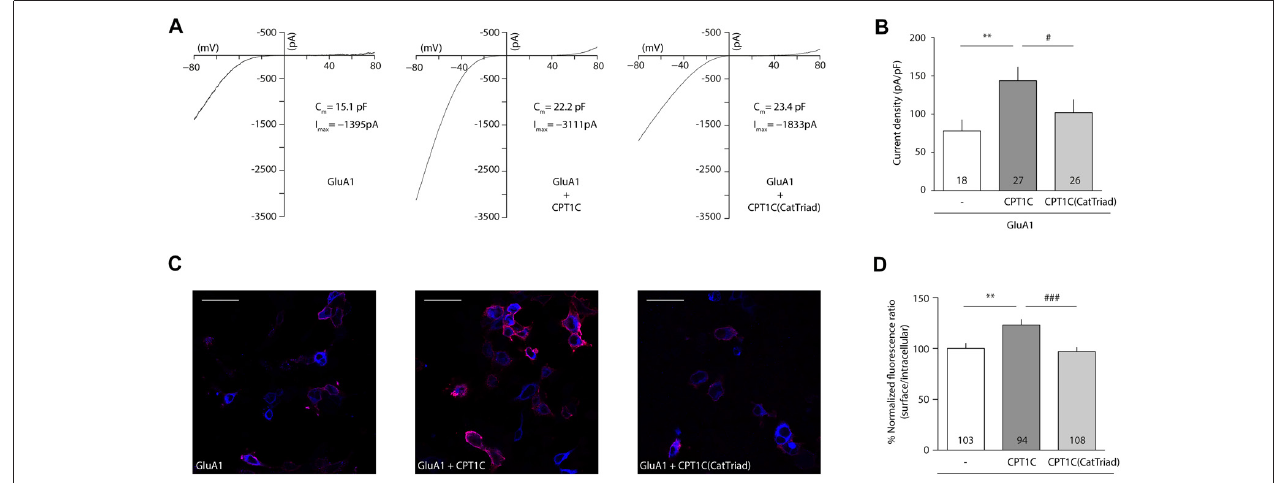
FIGURE 3 | CPT1C possesses a functional catalytic triad. (A) Examples of whole-cell currents between –80 mV and +80 mV evoked by 1 mM glutamate plus 25 µ M cyclothiazide in tsA201 transfected cells with GluA1 alone (GluA1+GFP), together with CPT1C or CPT1C(CatTriad). Cells with similar cell capacitance are shown. (B) Average of current density (–pA/pF) at –80 mV for GluA1 alone and together with CPT1C or CPT1C(CatTriad). CPT1C increased GluA1-mediated currents ( ∗∗ p < 0.01; Mann-Whitney-U-test) while mutation of Ser 252, His 470 and Asp 474 to alanine in CPT1C avoided the enhancement of the currents ( # p < 0.05; Mann-Whitney-U-test). Numbers in bars denote the number of recordings. (C) Representative confocal images of tsA201 cells co-transfected with GluA1+GFP (left panel), GluA1+CPT1C (middle panel) or GluA1+CPT1C(CatTriad), (right panel) where surface GluA1 was labeled with anti-GluA1-NT and Alexafluor 555 (red signal) and intracellular GluA1 was labeled with same anti-GluA1-NT primary antibody plus Alexafluor 647 (blue signal). Scale bars: 50 µ m. (D) Quantification of the GluA1 surface to intracellular ratio normalized to GluA1 and expressed as a percentage. The increment in surface expression due to CPT1C ( ∗∗ p <